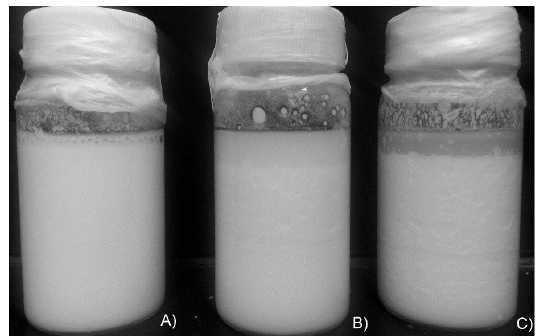
Figure 3. Emulsions of 1:4 (xylene:water) by weight containing ( A ) 200 mg of total monomer weight, ( B ) 400 mg of total monomer weight, and ( C ) 600 mg of total monomer weight. The pictures have been taken immediately after the samples were prepared.